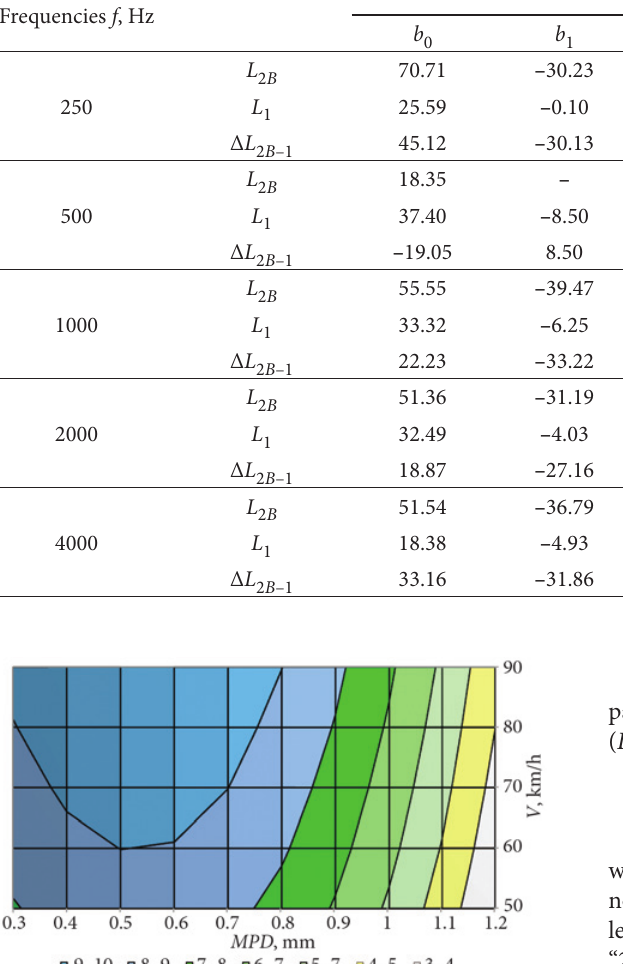
Table 1. Values of approximating polynomial coefficients Frequencies f , Hz